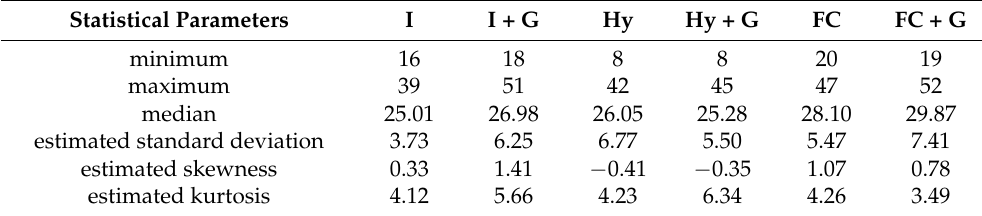
Figure 2. Microscopy images are shown of ( A ) initial state, ( B ) initial state and graphene, ( C ) hydrophilic agent, ( D ) hydrophilic agent and graphene, ( E ) functional coating, and ( F ) func- tional coating and graphene. SEM images at the magnification of 300 for the same morphological structures ( G – L ) are demonstrated. Table 1. Overview of statistical data for the different non-modified and modified nonwovens is shown, namely for (I) initial state, (I + G) initial state and graphene, (Hy) hydrophilic agent, (Hy + G) hydrophilic agent and graphene, (FC) functional coating and (FC + G) functional coating and graphene. Statistical